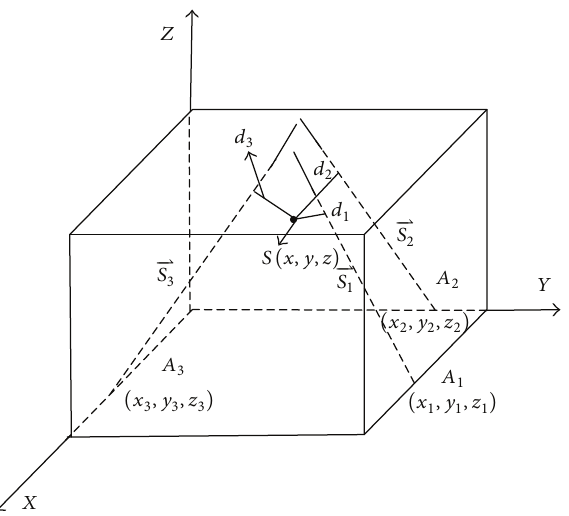
Figure 3: The map of three-array cross localization principle.